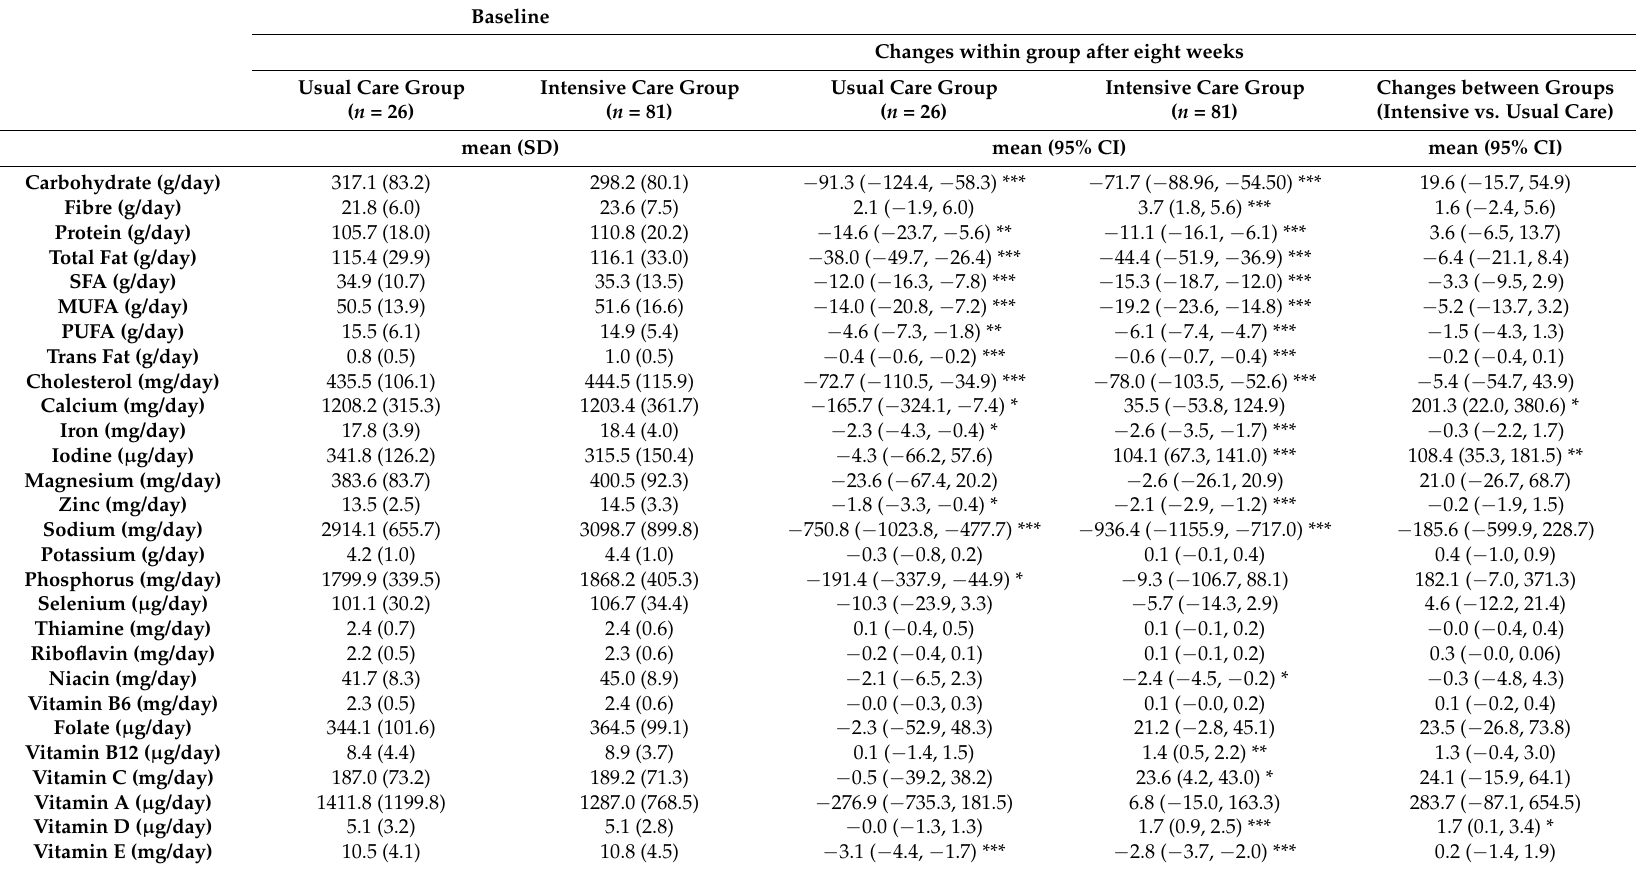
Table 2. Change in daily macro- and micronutrient intake after lifestyle intervention in children with abdominal obesity.